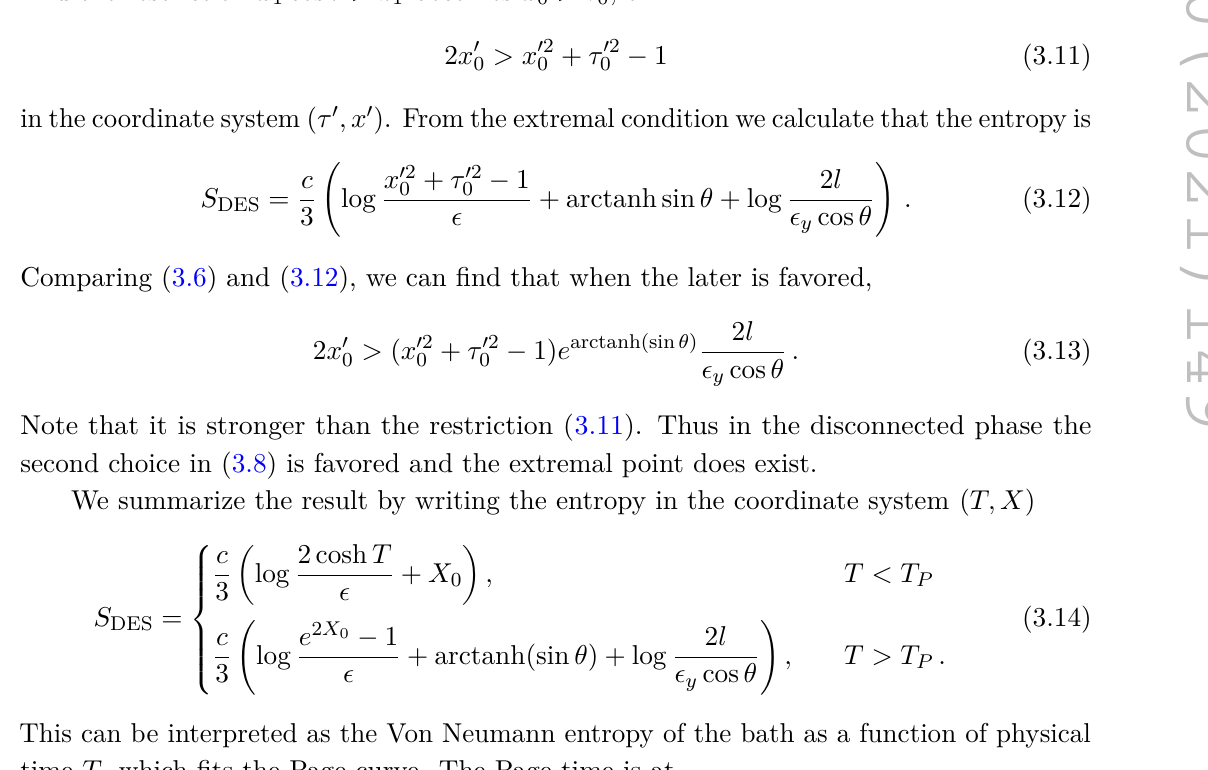
Figure 10 . The entropy S DES (in the unit of c We pick (cid:15) = 0 . 01 , (cid:15) y = 0 . 1 and l = 1